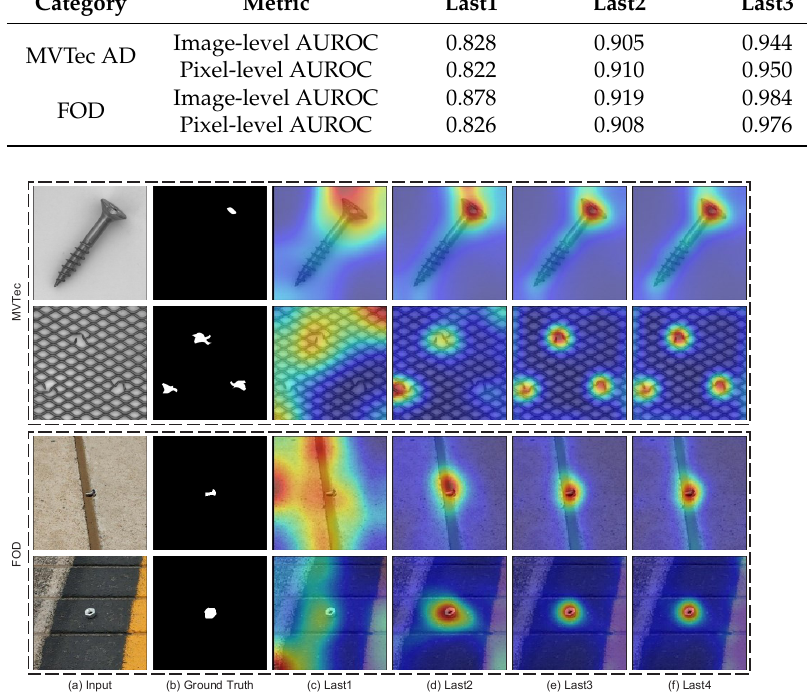
Figure 7. Qualitative results of MSFI with increasing hierarchical features on the MVTec AD and FOD datasets. Last l : anomaly map of MSFI using the hierarchical features from the last l convolu- tion blocks.